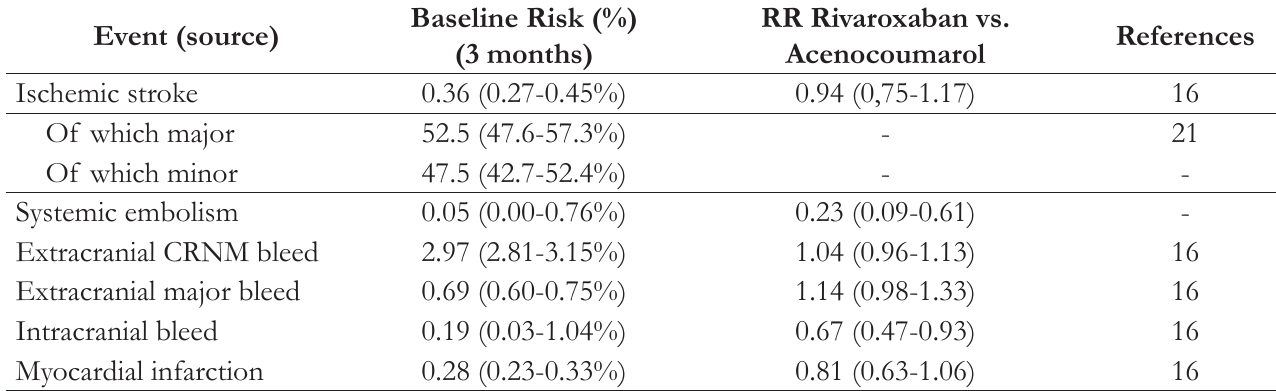
Table 1. Overview Clinical Input Data (95%